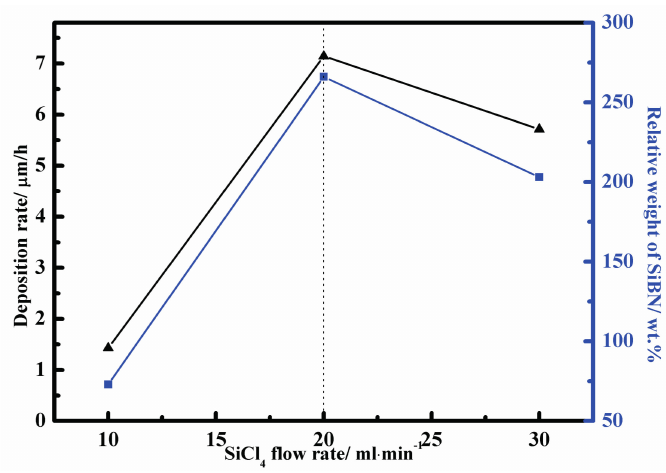
Figure 1. Deposition rate of SiBN coating and average weight percent gain of samples at various SiCl 4 flow